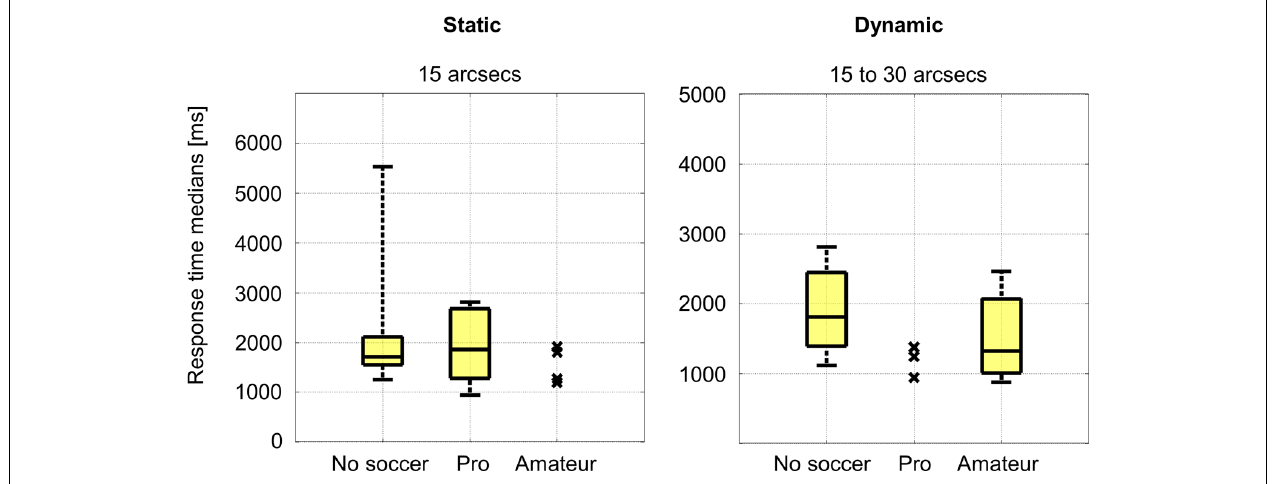
FIGURE 4 | Response time medians for the static stereo test and for the dynamic stereo test. The results for the lowest disparity difference and the lowest disparity difference range are shown